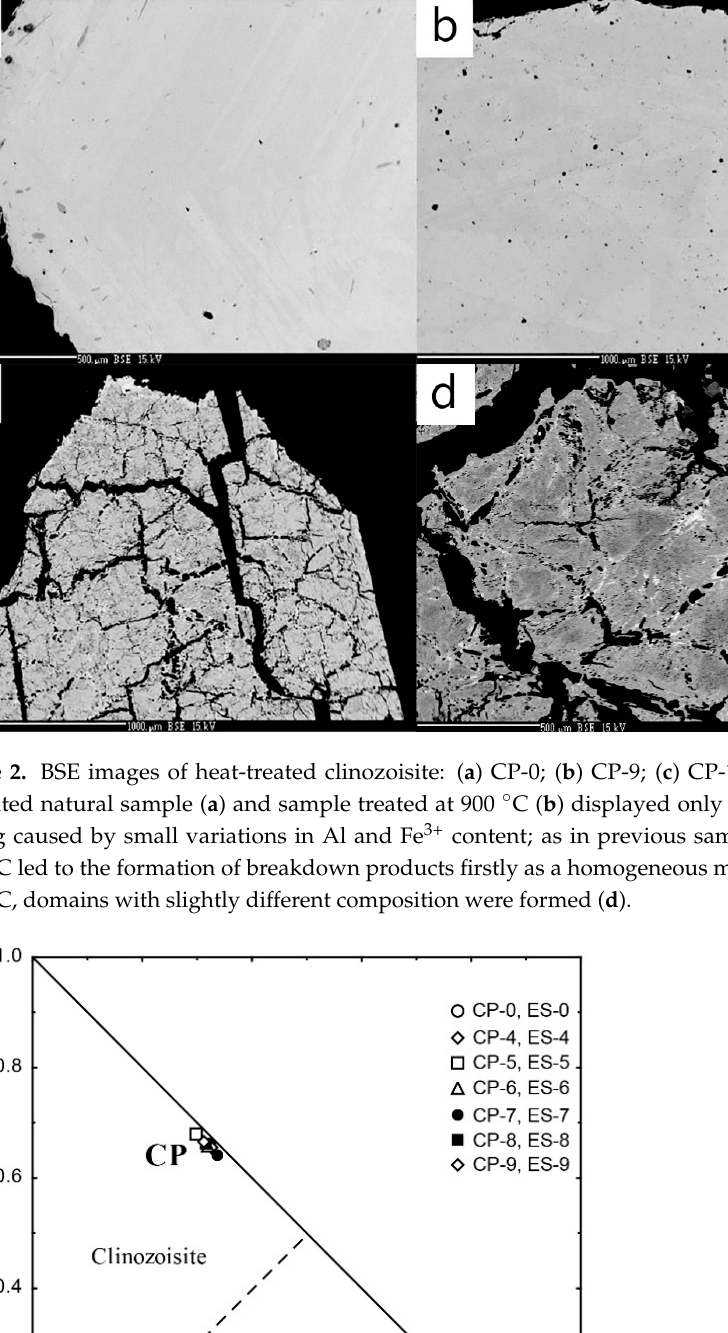
results from powder XRD. Table 5. Unit-cell parameters of the main breakdown products after the heat treatment of epidote (ES) and clinozoisite (CP).